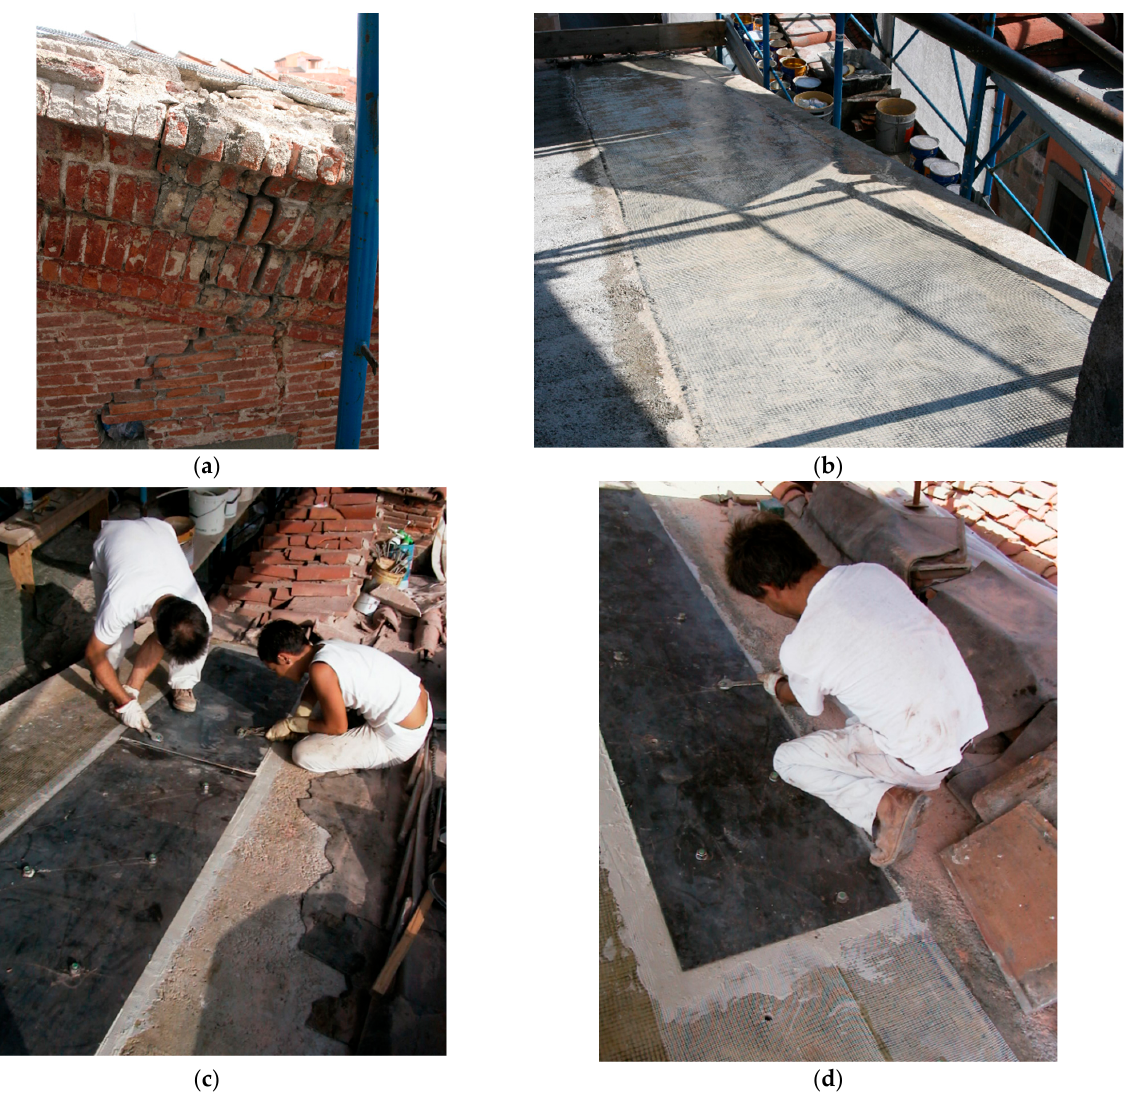
Figure 21. Phases of type A intervention: ( a ) edge joist before the intervention; ( b ) fixing of the carbon-fiber fabric; ( c ) upper steel plate; ( d ) glass-fiber net interposition for electrical insulation.